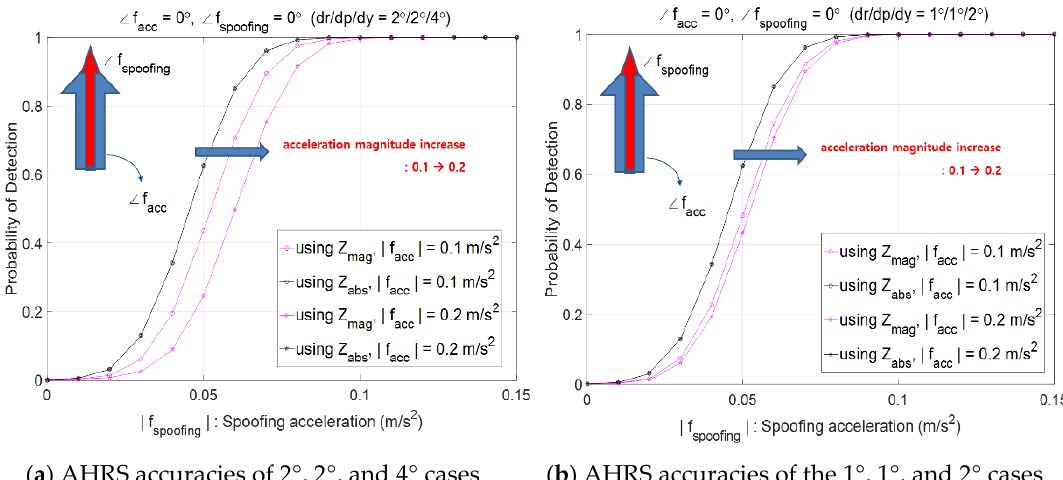
Figure 6. Probability of spoofing detection ,𝑃 𝑑,𝑚𝑎𝑔 and 𝑃 𝑑,𝑎𝑏𝑠𝑁 according to ∠ 𝒇 𝒔 with |𝒇 𝒂𝒄𝒄 | = 0.6 𝑚/𝑠 2 , where 𝒇 𝒔 is red color and 𝒇 𝒂𝒄𝒄 is cyan color; ( a ) 𝒇 𝒂𝒄𝒄 is heading north, ( b ) 𝒇 𝒂𝒄𝒄 is heading 30° east from north.